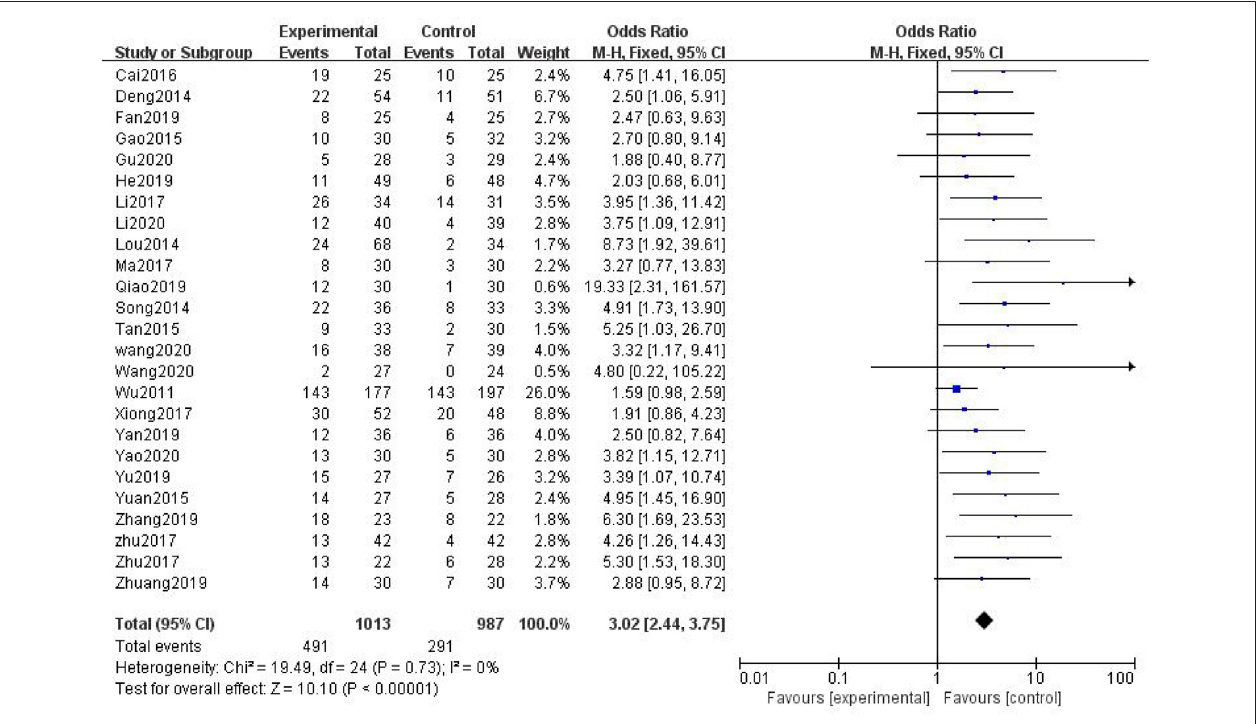
FIGURE 4 | Incidence of peripheral neurotoxicity.